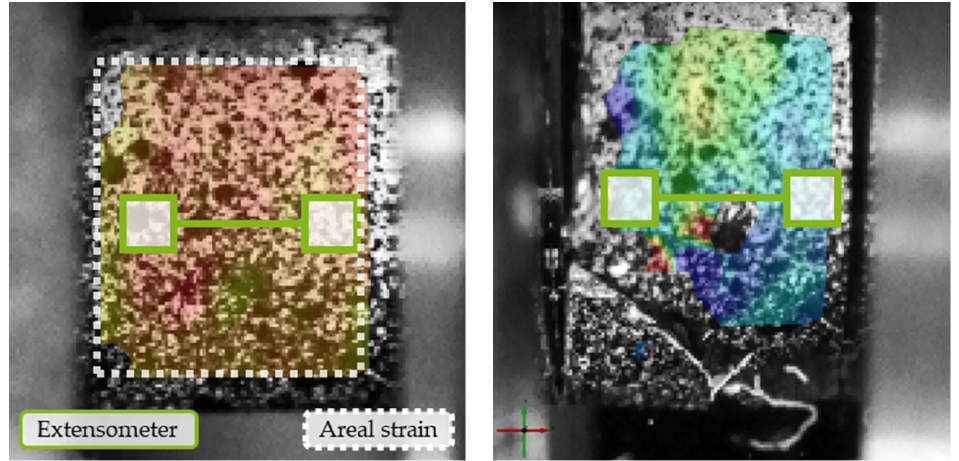
Figure 6. Areal and extensometer strain interpretation.